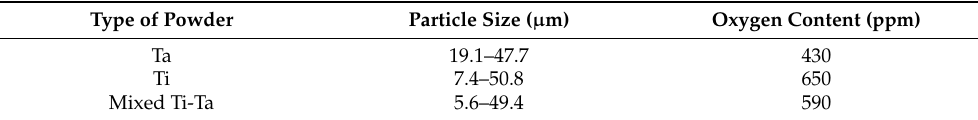
Table 3. The particle size and oxygen content of Ti, Ta and mixed Ti-Ta powders.